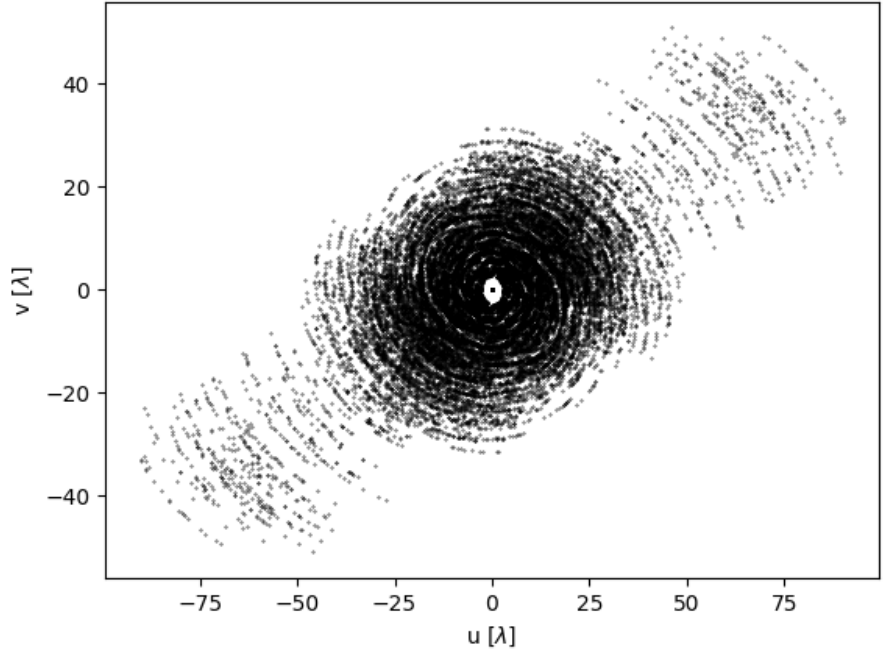
Figure 1. Achromatic uv -coverage of our NenuFAR observation, in units of central wavelength (in this case, the associated central frequency is 29.8 MHz). These are then modulated by our observing frequencies at each measurement. Note that the axes only extend to 75 λ